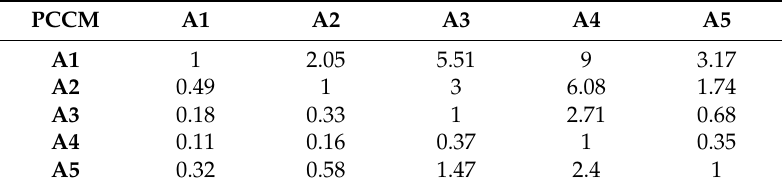
Table 3. Precise Consistency Consensus Matrix (PCCM).